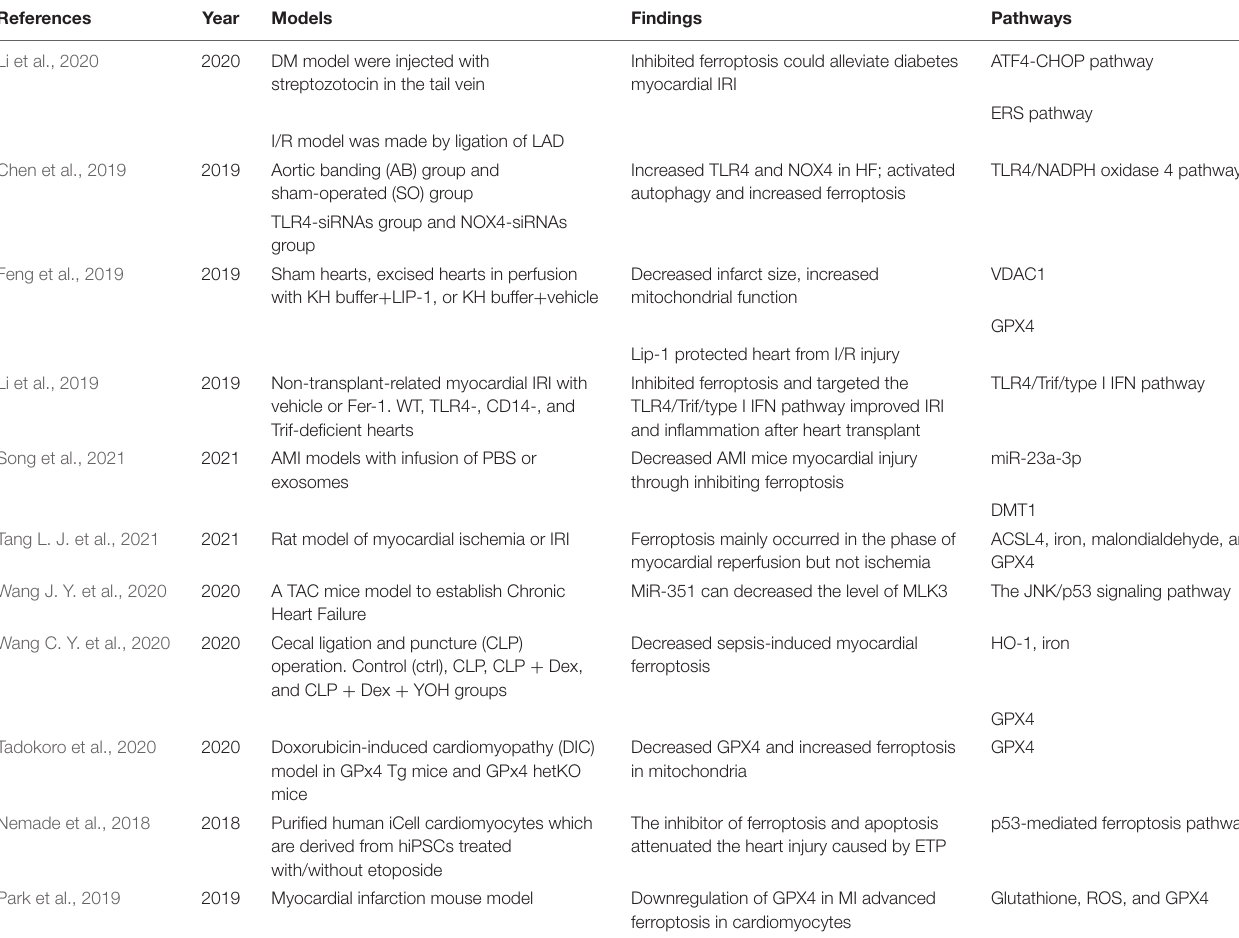
TABLE 1 | Existing studies suggesting the roles of ferroptosis in cardiovascular